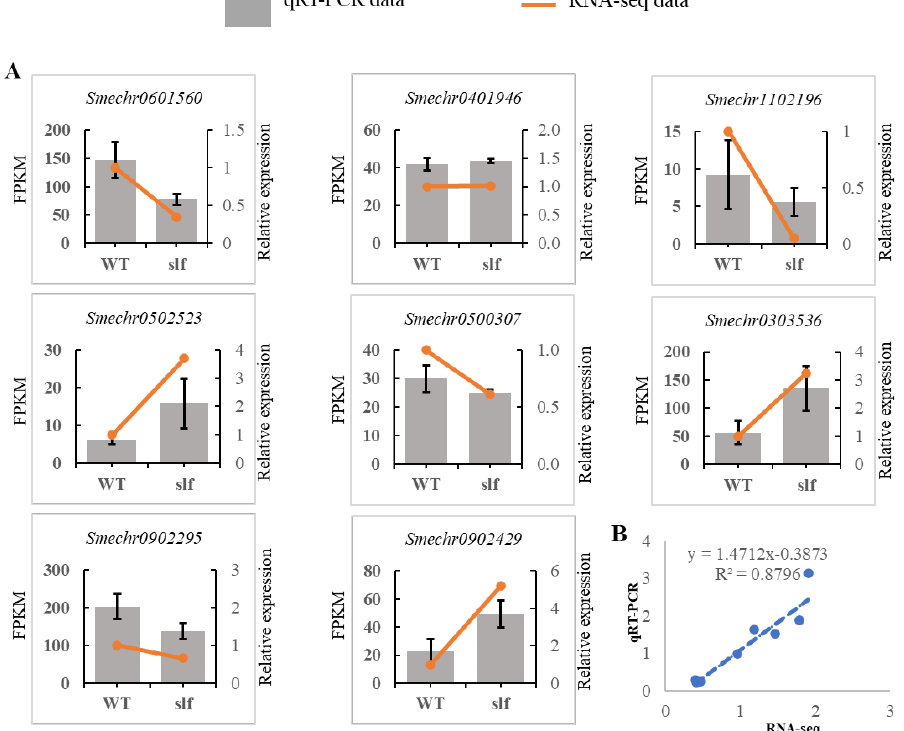
Figure 6. qRT-PCR verified the results of RNA-seq. The column diagram and line chart represented the data from qRT-PCR and RNA-seq, respectively. ( A ) The gene expression levels of qRT-PCR were normalized using the relative expression level of the internal control, tubulin gramma and WT (14–345) expression levels were normalized to 1. The data presented are the means from three biological replicates. ( B ) Pearson’s correlation of gene expression ratios ( slf /WT) between RNA-seq and qRT-PCR. The correlation of the fold change was analyzed by RNA-seq (x-axis) with qRT-PCR (y-axis)